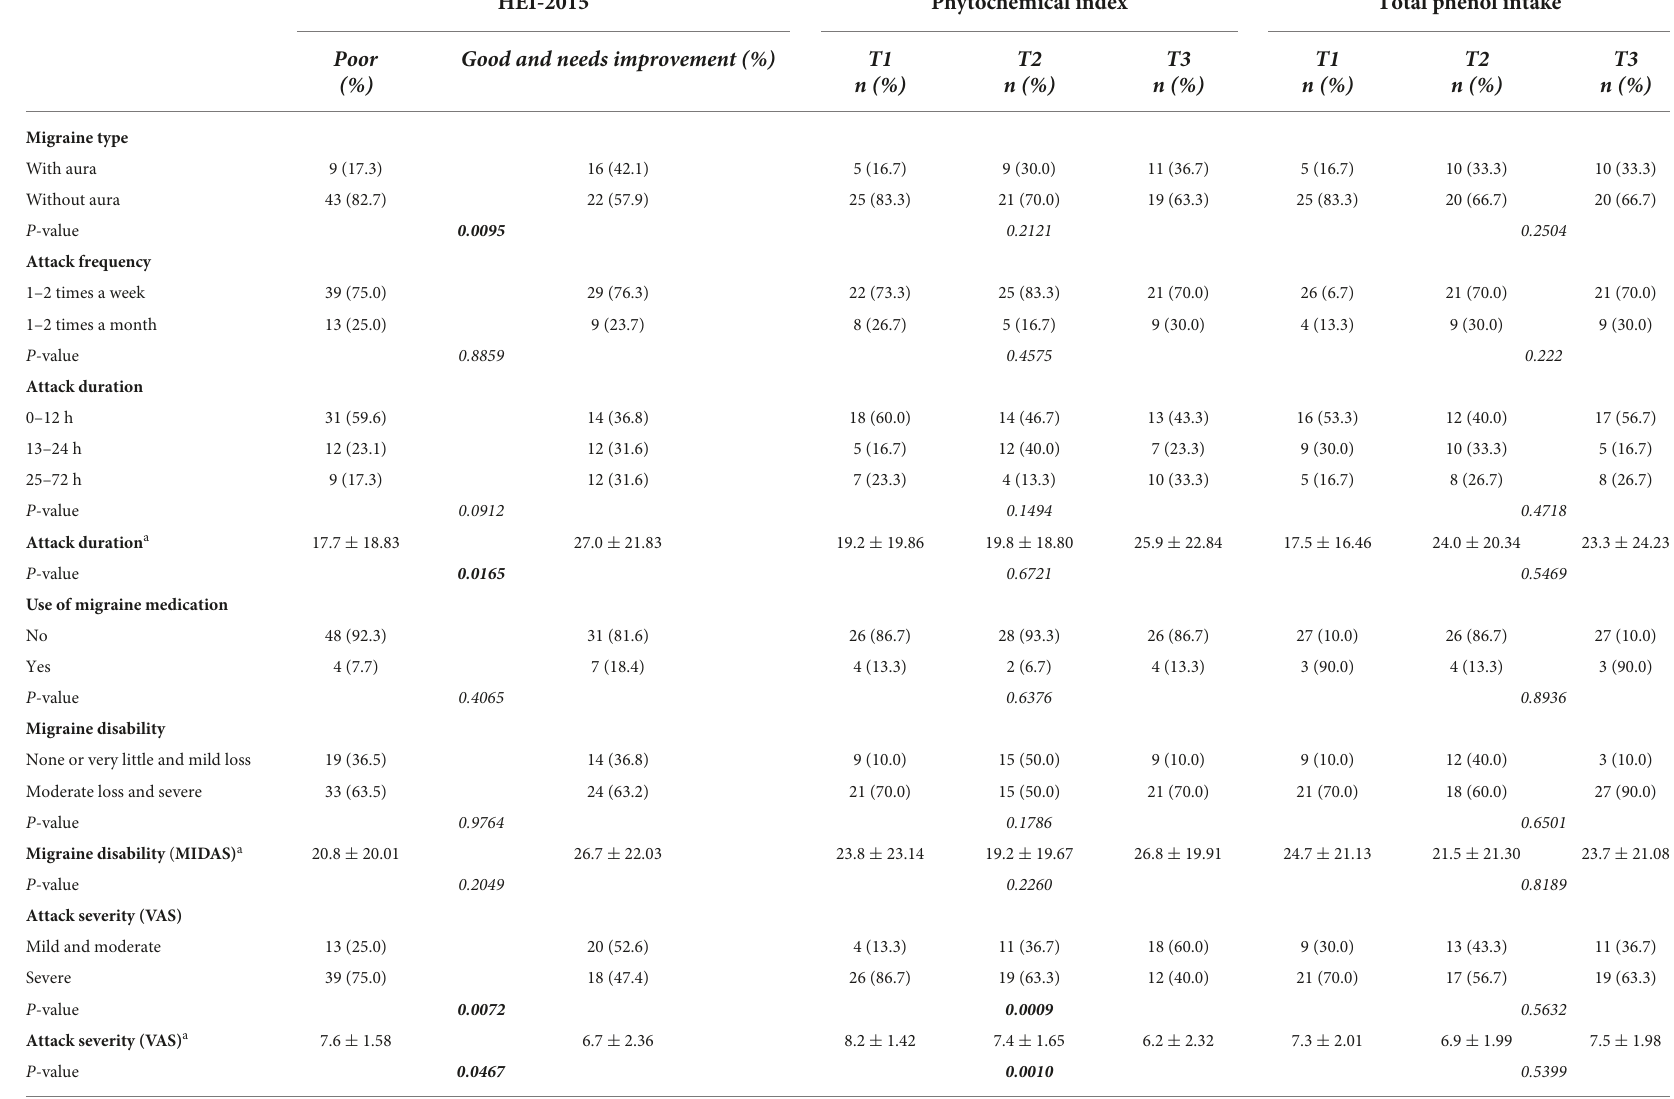
TABLE 1 Participants’ migraine characteristics according to diet quality, phytochemical index, and total polyphenol